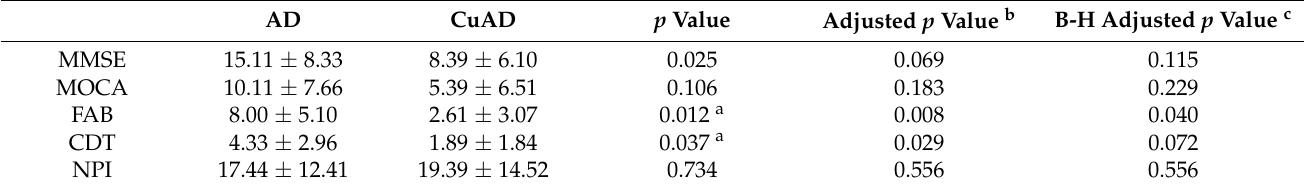
Table 4. Detailed values of the comparison of AD and CuAD neuropsychological test battery.